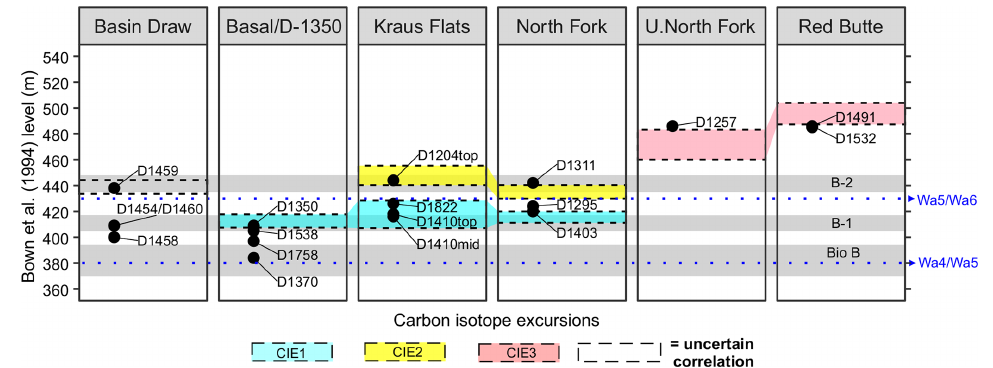
Figure 5. Selected Fifteenmile Creek fossil localities tied to the Bown et al. (1994) composite section. Shading follows Fig. 4, where stratigraphically lowest, middle, and highest carbon isotope excursions are outlined by blue, yellow, and red shading, respectively. The stratigraphic intervals associated with the faunal events described in Chew (2015) are shown as grey shaded regions. Points for the fossil localities incorporate some stratigraphic uncertainty and averaging of collecting levels discussed in the text. Faunal zone boundaries are shown as blue dotted lines based on Bown et al. (1994). For more detailed ranges of collecting levels associated with the localities, see Fig. 3.